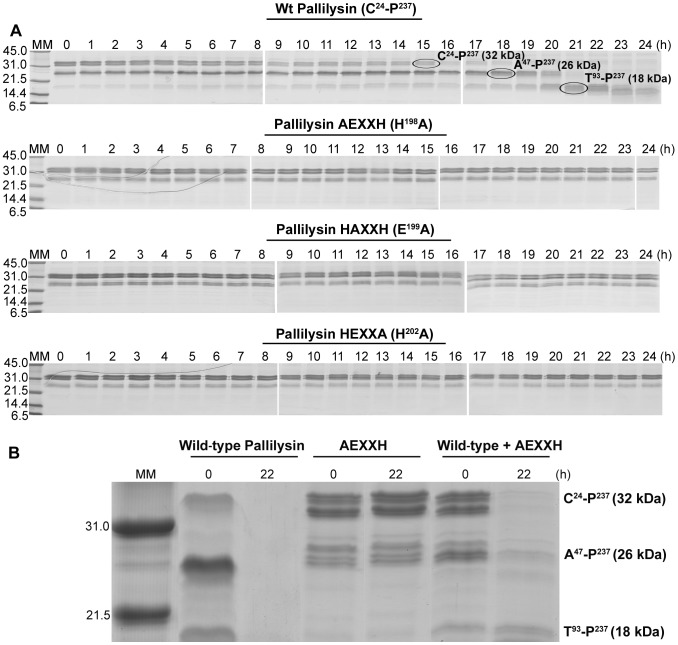
Pallilysin is autocatalytically activated via sequential inter-molecular cleavages at residues T46 and Q92.(A) Recombinant wild-type pallilysin (C24-P237) and active site mutant pallilysin (AEXXH [H198A], HAXXH [E199A], and HEXXA [H202A]) purified from E. coli (500 µg) were incubated at 37°C for 24 h. Samples (10 µg) were removed every hour from 0–24 h post-incubation and analyzed by SDS-PAGE. The generated autocatalytic peptide bands corresponding to proteins ranging in mass from approximately 32 kDa to 18 kDa (circled) were analysed by Edman sequencing. The negative control Tp0453 failed to undergo autolysis (data not shown). (B) Purified recombinant wild-type (100 µg) and mutant (AEXXH [H198A]) pallilysin (100 µg) were incubated independently and together at 37°C for 22 h. Samples were removed at 0 and 22 h post-incubation and analyzed by SDS-PAGE for the presence or absence of autocatalytic peptides. Each lane contains approximately 6 µg of protein (in the absence of degradation). Numbers to the left of the lanes indicate the size (kDa) of the corresponding molecular mass (MM) markers.